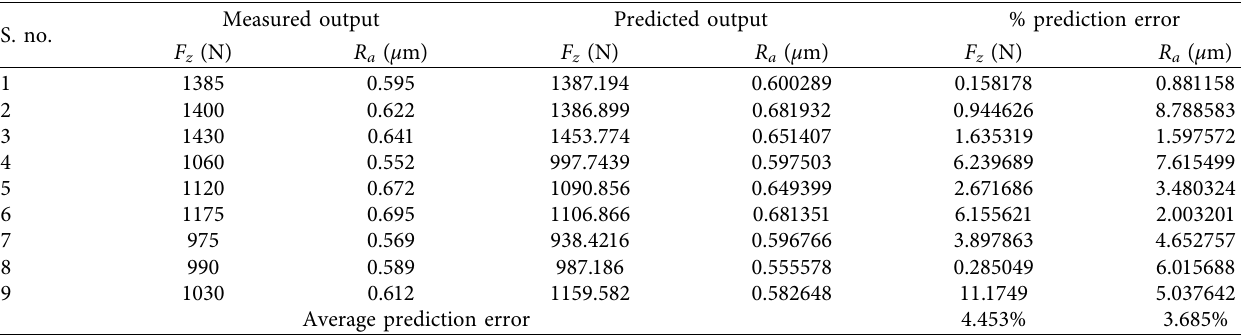
Table 9: Percentage prediction errors for test